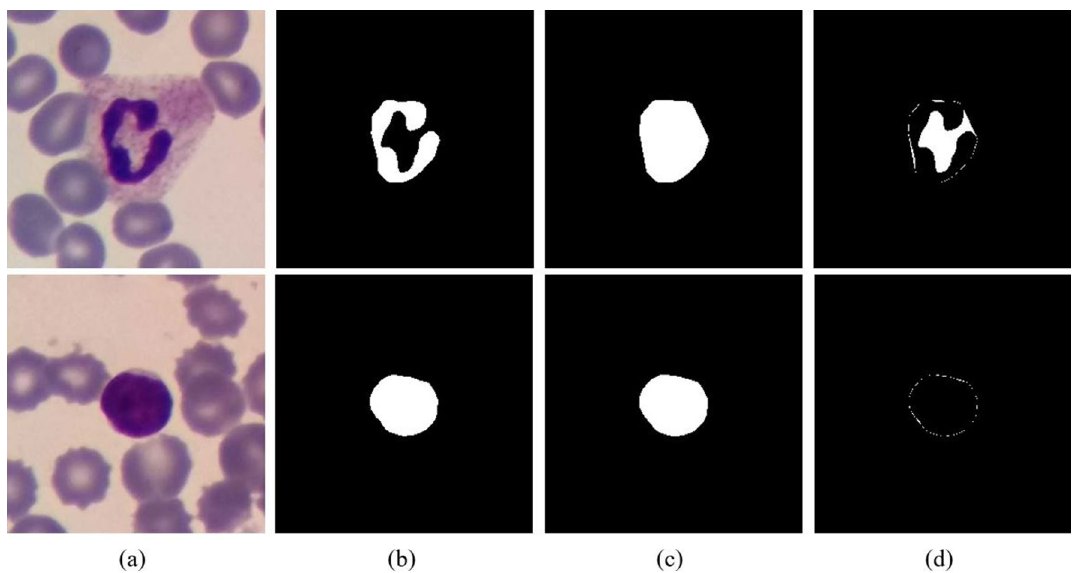
Figure 5. The cytoplasm detection. The first row and the second row are neutrophil and lymphocyte, respectively. (a) RGB image, (b) nucleus, (c) convex hull of the nucleus, (d) the representative of the cytoplasm